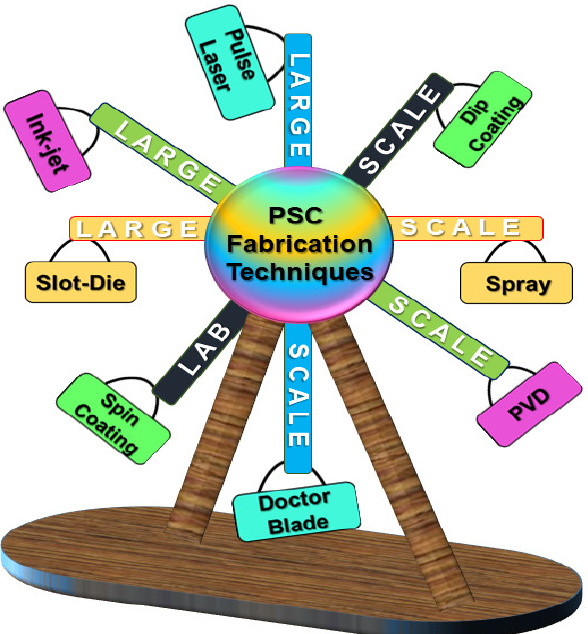
Figure 3. Schematic diagram of various reported methods for PSC layers deposition.